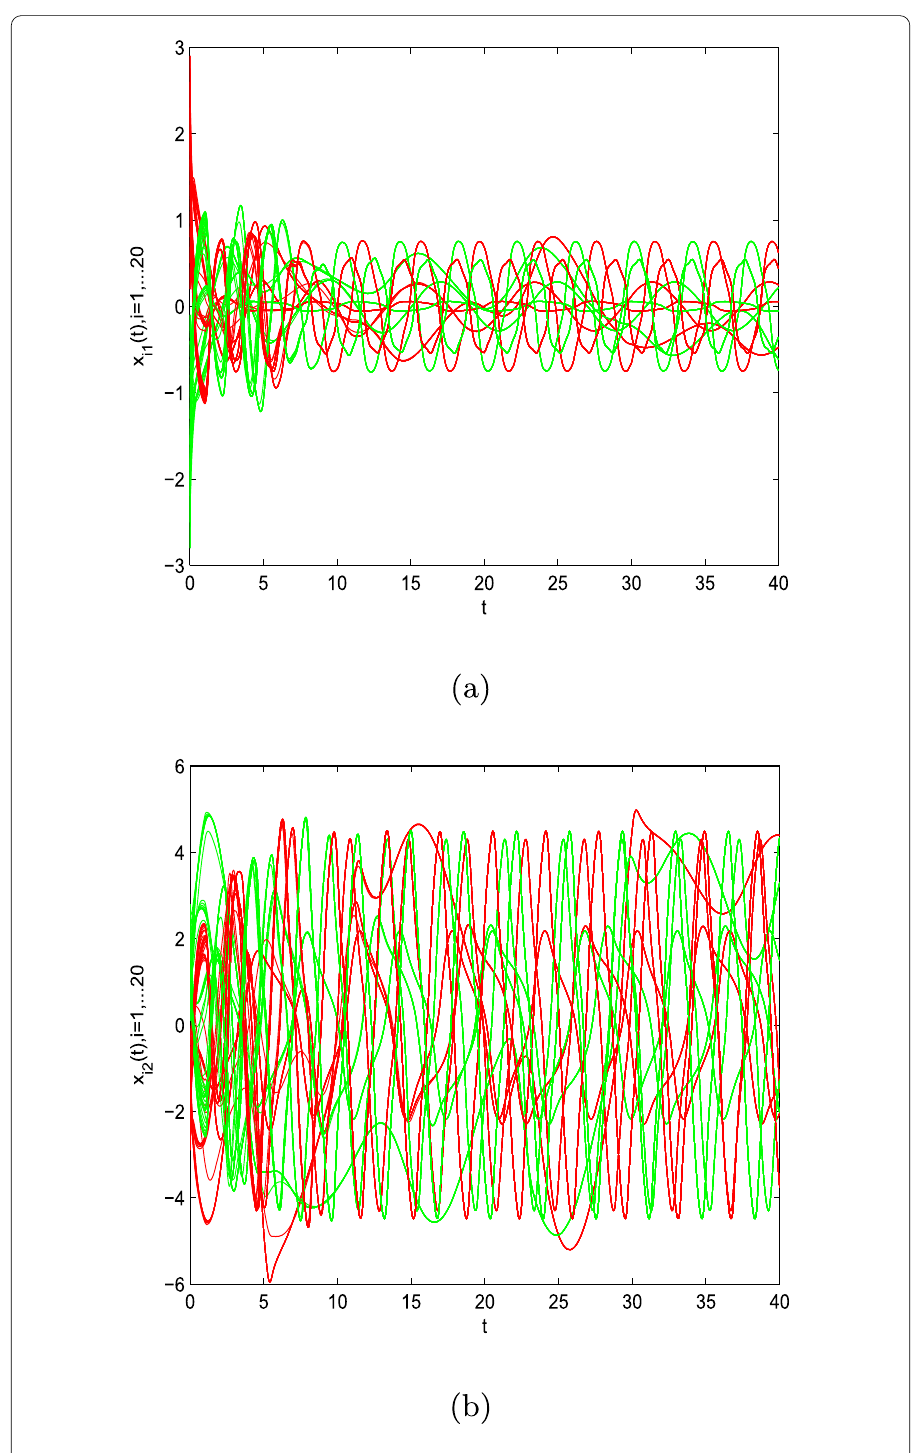
Figure 2 The state trajectories of x i 1 , x i 2 in system